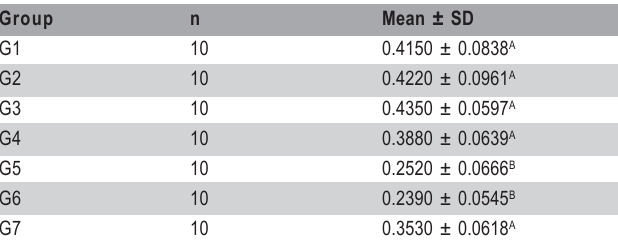
Statistically significant differences are expressed by different letters (p<0.05). Table 2 -Table 2 -Table 2 -Table 2 -Table 2 - Amount of material emoved at 11 mm (measured from